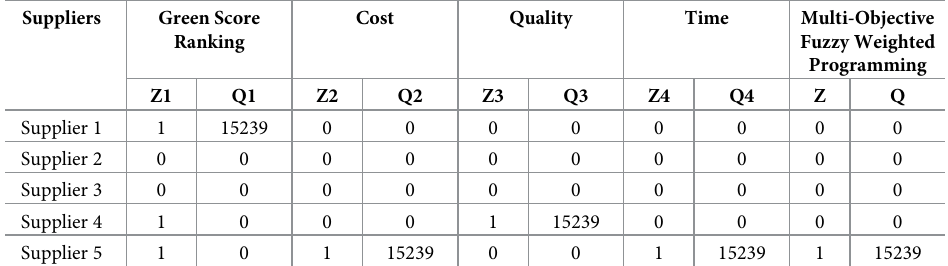
Table 15. Qualified supplier(s).